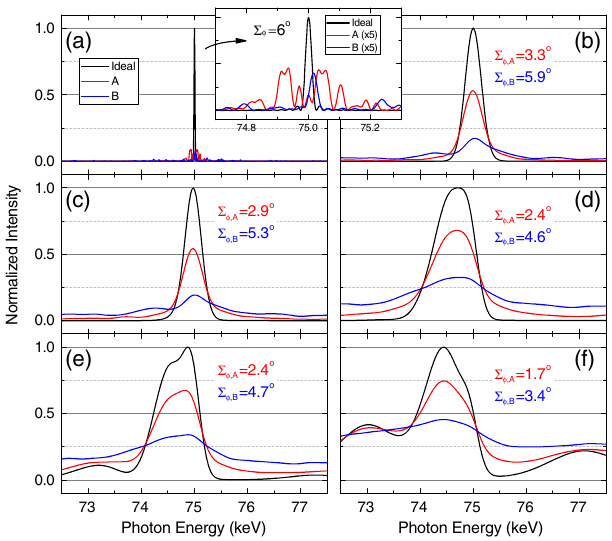
FIG. 4. Spectra of UR calculated with the magnetic field distributions in the undulator models A and B, for six different conditions (a) – (f) defined in Table I.